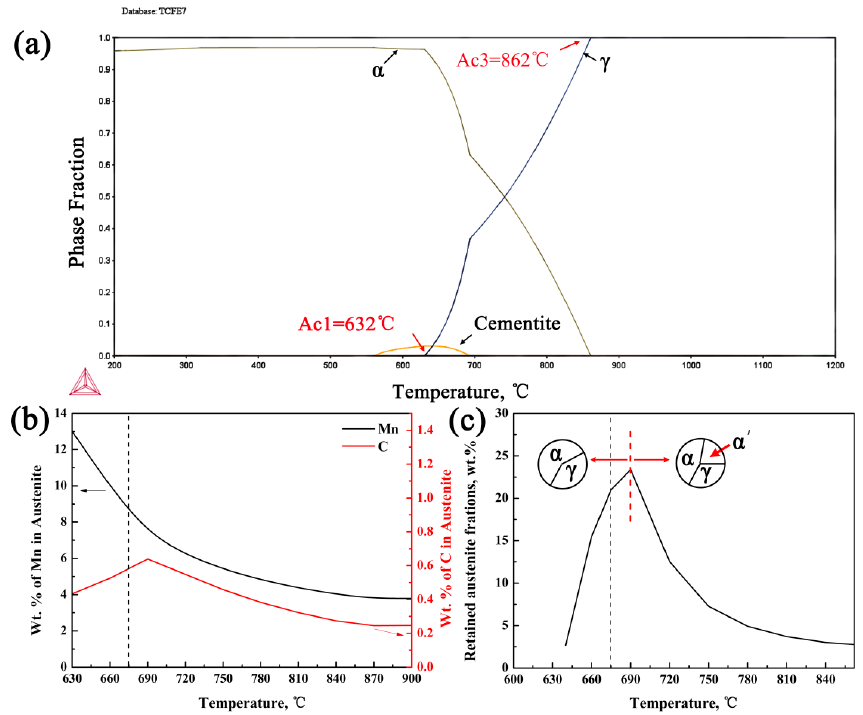
Figure 2. ( a ) Phase composition of experimental steel at different temperatures; ( b) temperature dependence of C and Mn contents in austenite; ( c ) calculation of retained austenite (RA) fractions at different temperatures ( γ : austenite, α : ferrite, α ’: martensite).